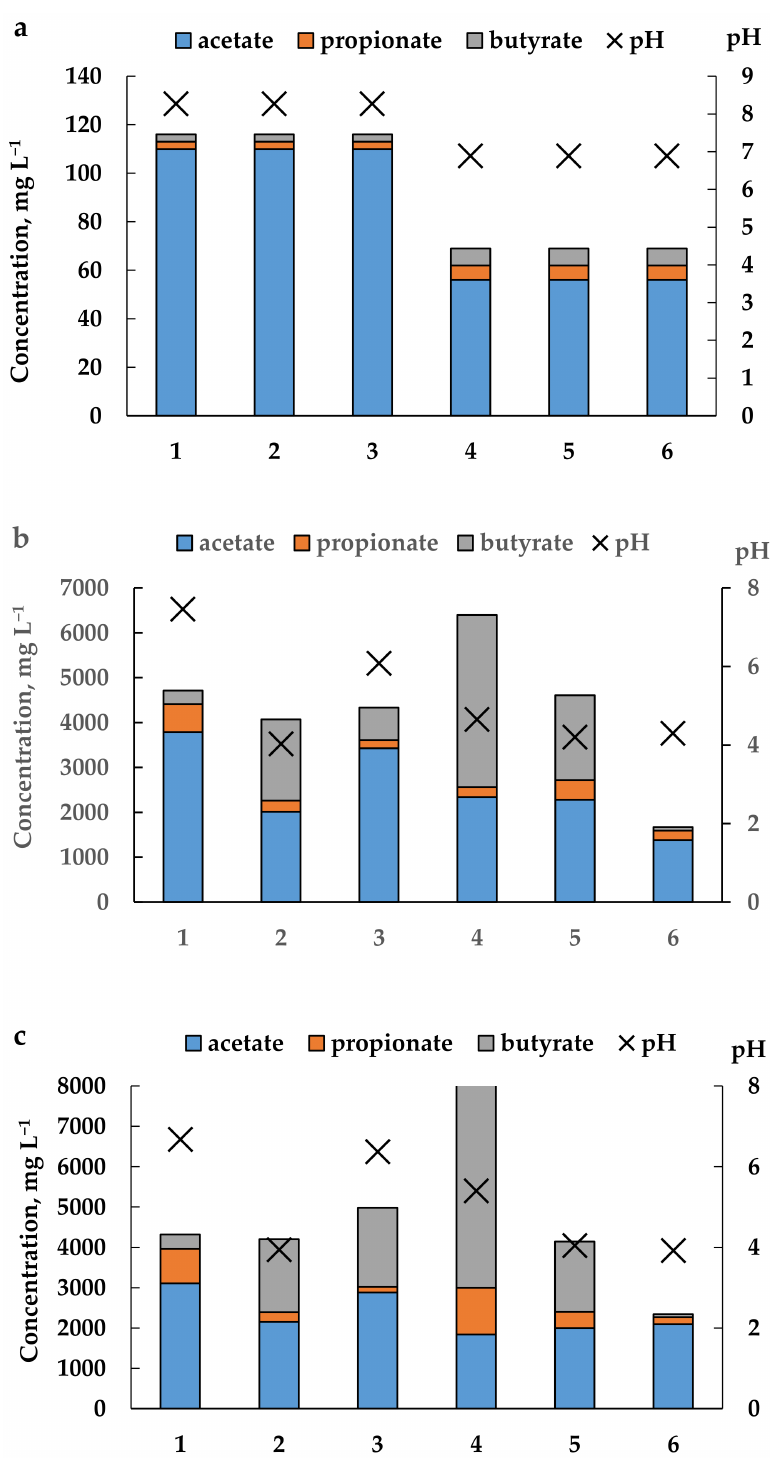
Figure 3. Production of VFA in reactors on days 0 ( a ), 2 ( b ) and 8 ( c ) of incubation. 1—control 1 (inoculum 1 without treatment); 2—inoculum 1 after acid inactivation; 3—inoculum 1 after thermal inactivation; 4—control 2 (inoculum 2 without treatment); 5—inoculum 2 after acid inactivation; 6—inoculum 2 after thermal